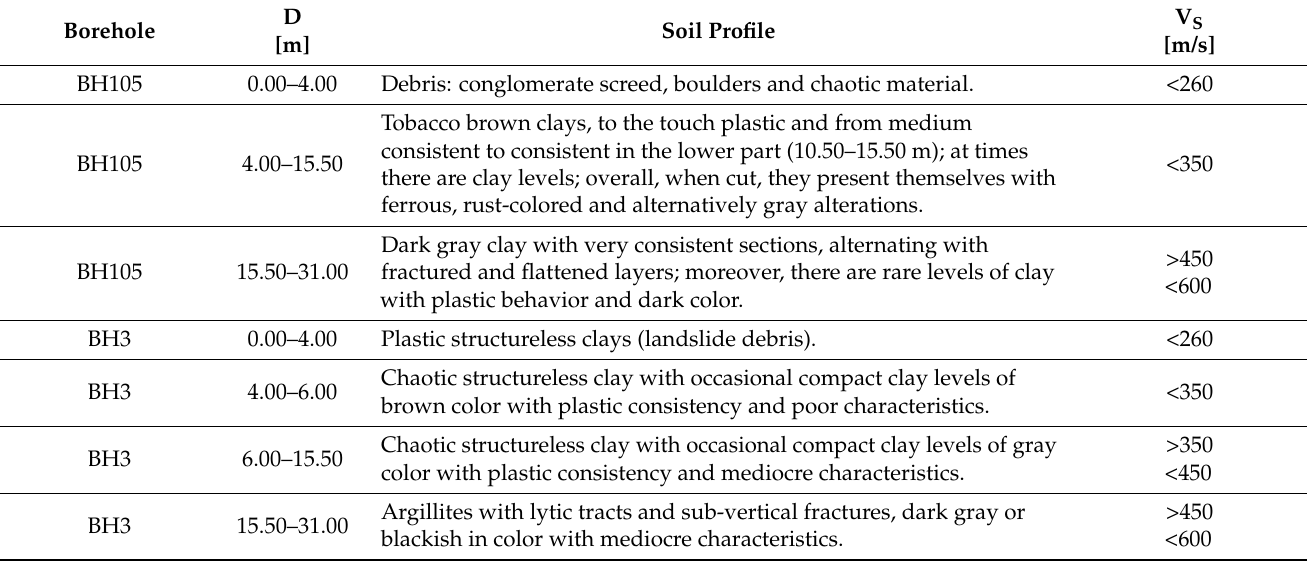
Table 1. Soil profile for Caronia